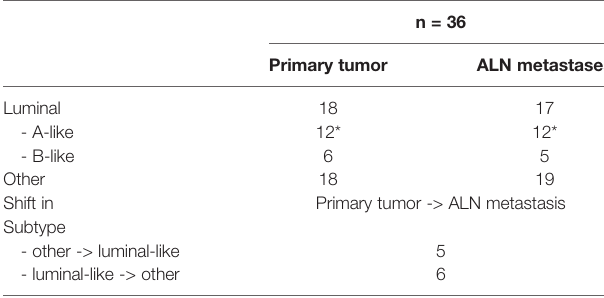
TABLE 2 | Distribution of the BC surrogate intrinsic subtypes, revealing a shift in subtype between PTs and synchronous ALN